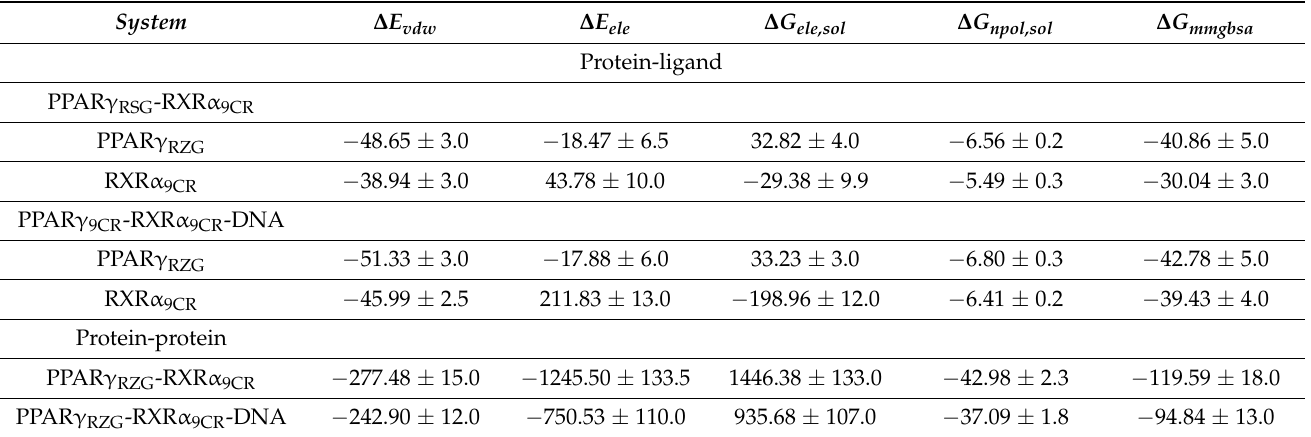
Table 1. Binding free energy components for protein-ligand and protein-protein interactions of the RXR α -PPAR γ , and RXR α -PPAR γ -DNA systems are calculated by using MMGBSA approach (values are in